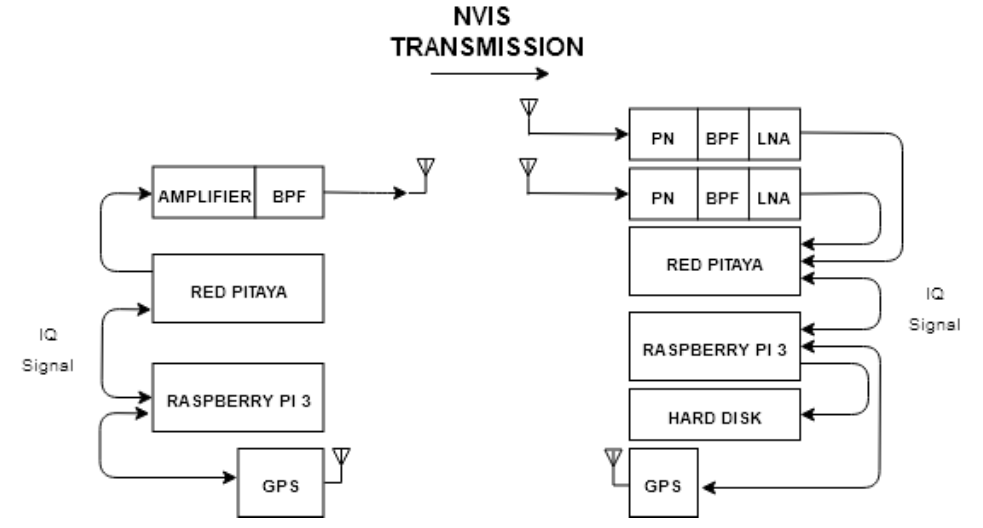
Figure 1. Schematic of the remote sensing platform.